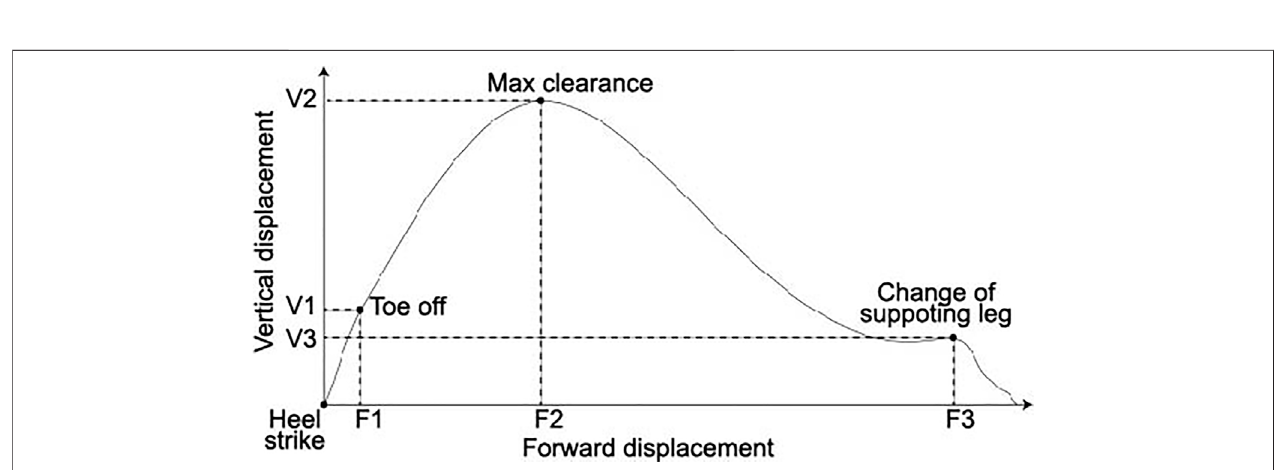
FIGURE2 | Foot trajectory and sixspatial featuresofthe foot trajectory:forward and vertical displacements from the heel strike totoe-off (F1and F2, respectively), maximum clearance (F2 and V2, respectively), and change of supporting leg (F3 and V3, respectively). The vertical and horizontal axes are the vertical and forward displacements,